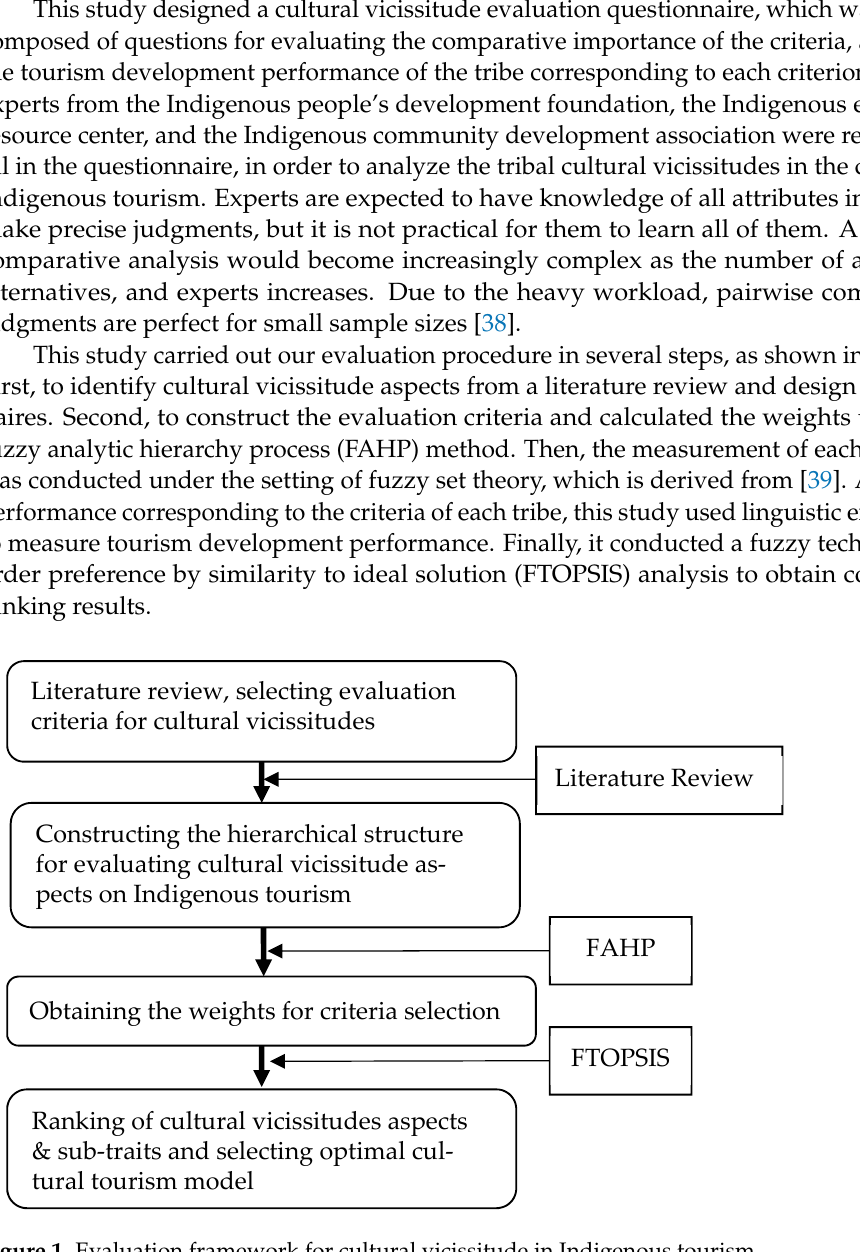
Figure 1. Evaluation framework for cultural vicissitude in Indigenous tourism.